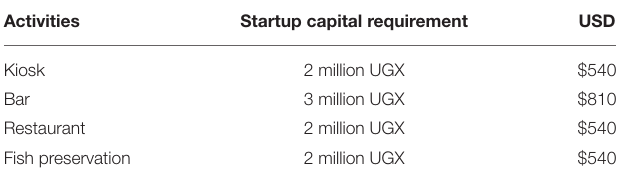
TABLE 1 | Enterprise start-up capital, BS.